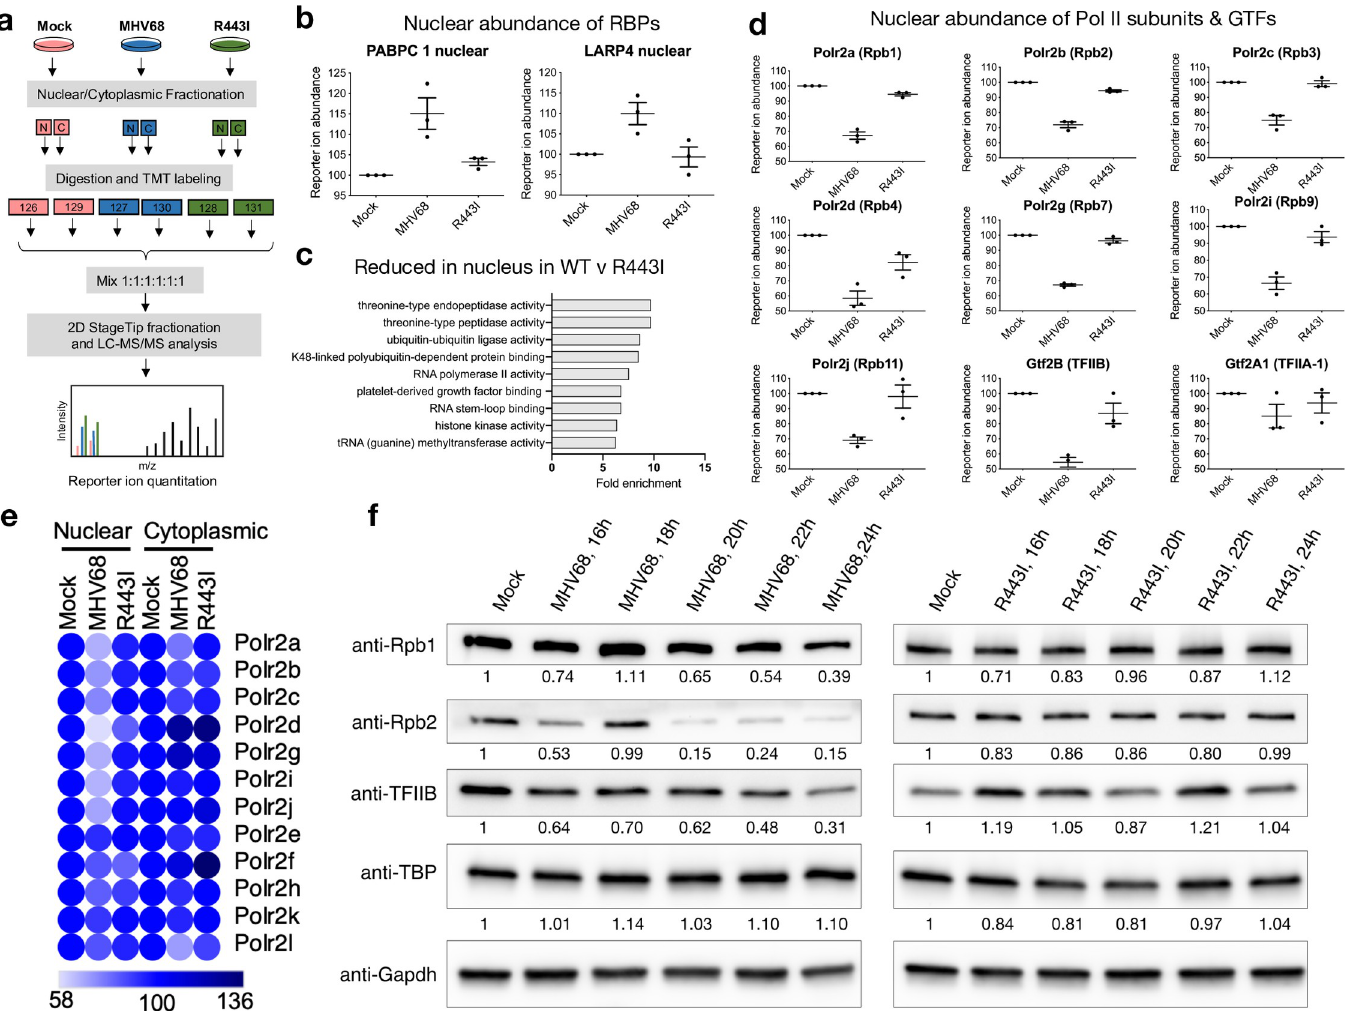
Fig 3. Pol II subunits are depleted in the nucleus of MHV68 infected cells in an RNA decay dependent manner. (A) Diagram showing the experimental setup for the TMT-MS. (B) Graphs showing the nuclear distribution of poly(A) binding proteins from the TMT-MS data. Graphs display the mean with SEM of 3 biological replicates. (C) Molecular functions classification by Pantherdb of nuclear proteins differentially expressed by 1.15 fold or more in R443I compared to WT MHV68 infection of 3T3 cells in the TMT-MS data. Categories with fold enrichment greater than 5 are shown. (D) Graphs showing the relative nuclear abundance of 7 Pol II subunits and 2 general transcription factors from the TMT-MS data that are reduced in MHV68 infection compared to R443I. Graphs display the mean with SEM of 3 biological replicates. (E) A heatmap displaying normalized reporter ion abundance of all 12 Pol II subunits in the nucleus and cytoplasm, where light blue represents lower abundance and dark blue represents higher abundance. (F) Representative western blot showing the levels of Rpb1, Rpb2, TFIIB and TBP upon mock infection versus infection with WT MHV68 or R443I MHV68 in MC57G cells at the indicated times post infection in whole cell lysate. Gapdh serves as a loading control. Densitometry of band intensity was normalized first to Gapdh and then mock infection are indicated below